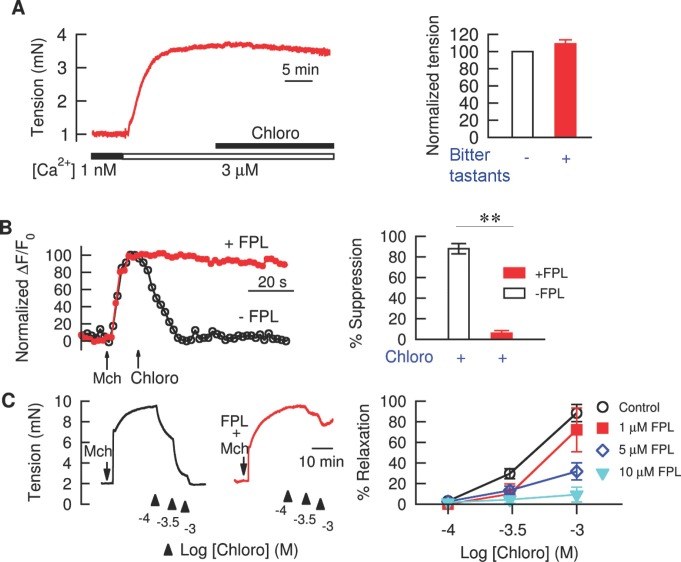
Suppression of [Ca2+]i by inhibiting L-type VDCCs is necessary for bitter tastant-induced bronchodilation of Mch precontracted mouse airways.(A) Clamping [Ca2+]i prevented bitter tastants from causing bronchodilation. Mouse airway rings were permeabilized with α-toxin (see Method), and extracellular [Ca2+]i was set at 1 nM and then switched to 3 µM as indicated under the trace. Seven individual experiments (two for denatonium, two quinine, and three chloro all at 1 mM) show responses similar to that shown on the left, so the results were pooled and displayed on the right. Each ring's normalized tension is its tension at the experiment's end divided by its tension just prior to application of bitter tastants, times 100. (B) FPL 64176 (FPL), an L-type VDCC agonist, prevented chloro from reversing the [Ca2+]i rise induced by 100 µM Mch. Left panel: a typical time course; ΔF/F0 for each curve is scaled to have a value of 100 at the peak before chloro is added. Right panel: average results of 16 cells. The values are represented as (ΔF/F0 at the peak after Mch−ΔF/F0 at 30 s after chloro)/(ΔF/F0 at the peak after Mch−ΔF/F0 at basal)×100 (i.e., the decrease due to chloro divided by the increase due to Mch). **p<0.01, control versus +FPL. (C) FPL dose-dependently reversed chloro-induced bronchodilation (using tension as a proxy measure) in Mch precontracted airways (n = 5–7 independent experiments). Data on the right panels are mean ± SEM. % relaxation = tension decrease due to chloro divided by tension increase due to Mch, ×100. The tension decrease at each concentration of chloro is measured once the tension stabilizes. The tension decrease at each increased concentration is always measured relative to the peak tension (i.e., it is total decrease, not the incremental decrease due to the additional chloro which was added).